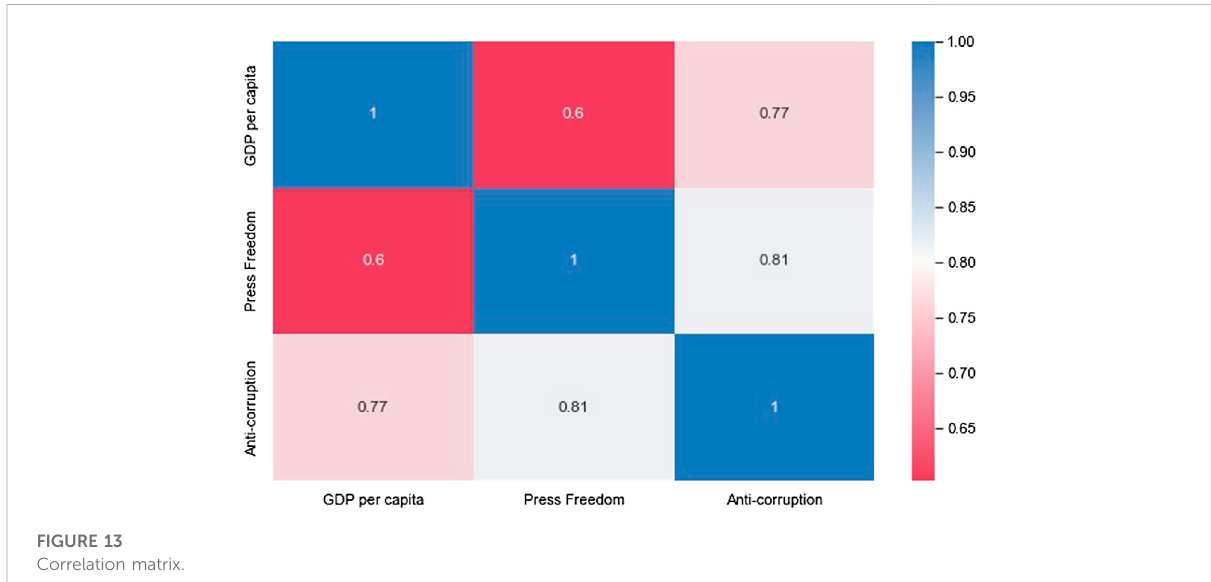
FIGURE 13 Correlation